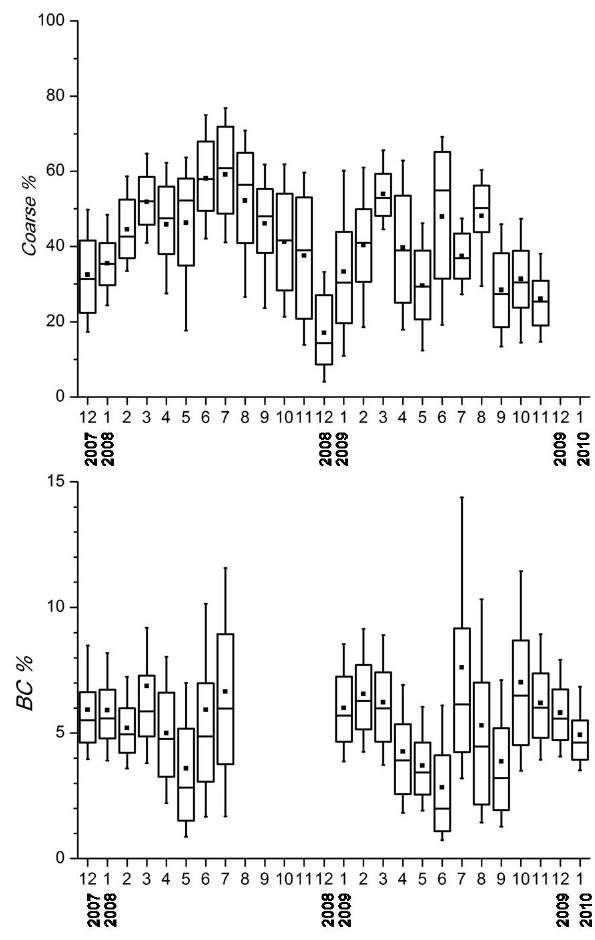
Fig. 8. (upper) Fraction of the coarse mode (PM 10 –PM 2 . 5 ) of the PM 10 mass. (lower) Fraction of BCe of the PM 10 mass. In figures, 10% percentile (error bar), 25% percentile (box bottom), median (horizontal line), mean (rectangle), 75% percentile (box top), and 90% percentile (error bar) calculated from hourly averages are pre- sented for each